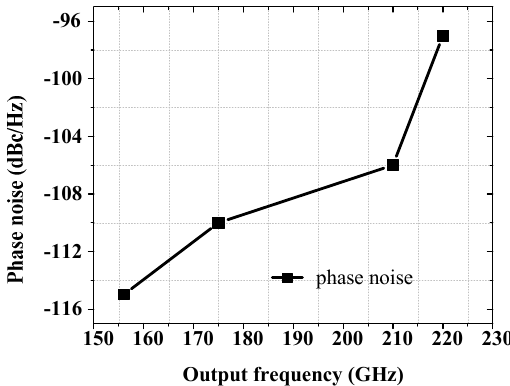
Figure 16. The output power at different frequencies.